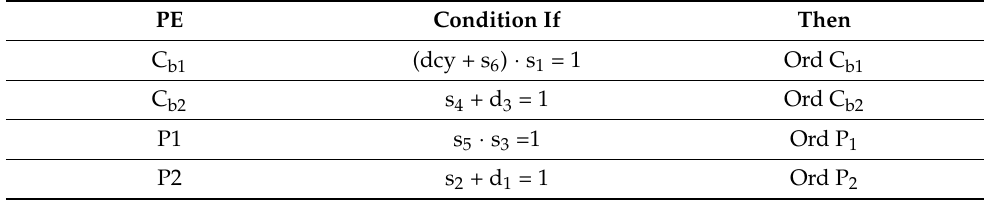
Table 4. Set of global